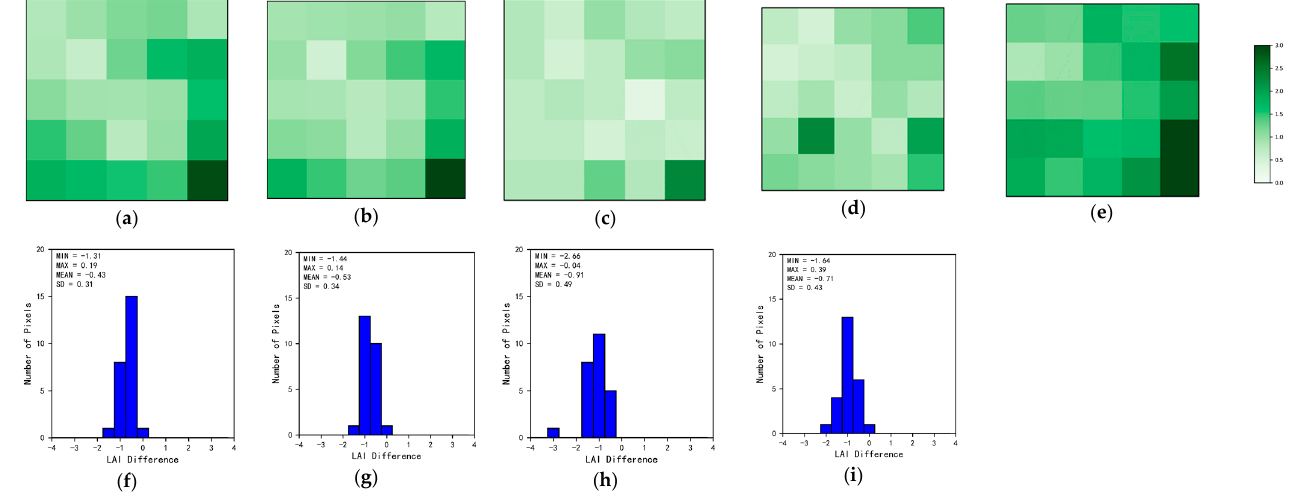
Figure 4. Images of the LAI-TCA ( a ), the LAI-GRNN ( b ), the VIIRS ( c ), the MODIS ( d ) and the LAI values acquired from high-resolution reference maps ( e ) at the SouthWest_1 site on Day 230, 2013. ( f – i ) Statistical distributions of discrepancies between the LAI-TCA, the LAI-GRNN, the VIIRS, the MODIS and the LAI values acquired from high-resolution reference maps.